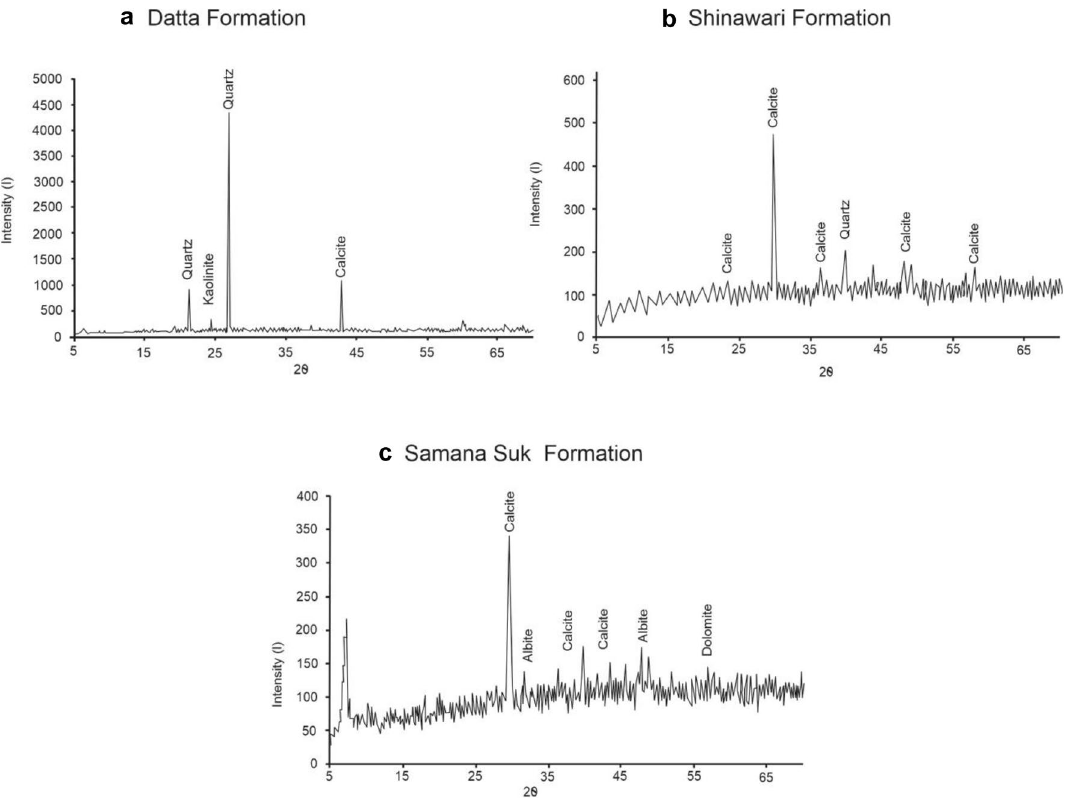
Fig. 5 XRD analysis of the selected samples (average) from Datta ( a ), Shinawari ( b ), and Samana Suk ( c ) formations, Kala Chitta Range, North- west Pakistan